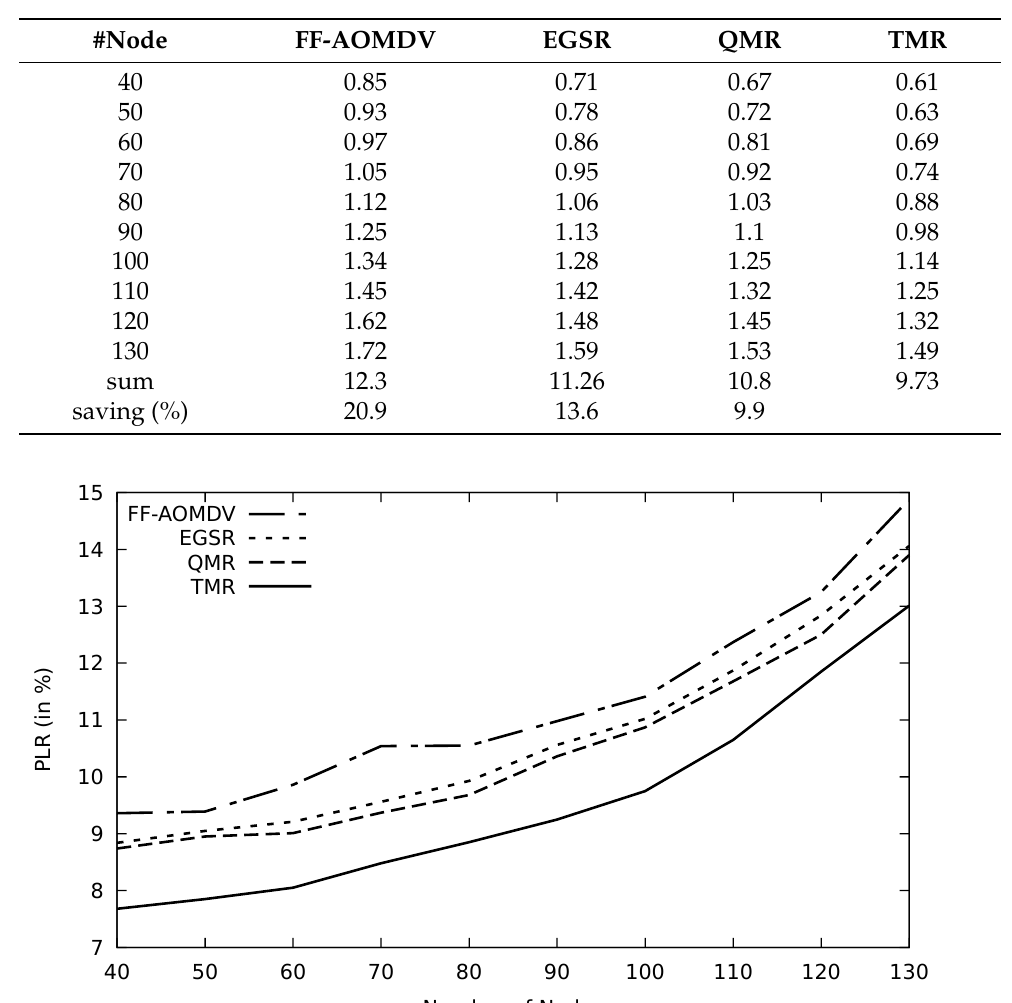
Table 4. Number of nodes vs. end-to-end delay of Figure 15.